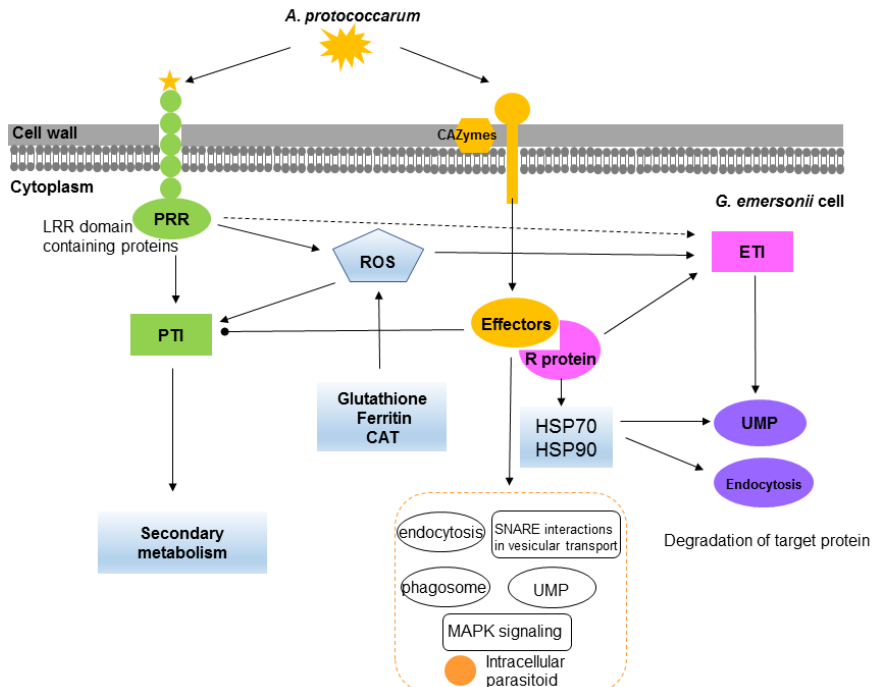
Figure 6. Schematic diagram showing the basic interaction of microalga G. emersonii and endoparasite A. protococcarum . Similar to plant, G. emersonii cells can perceive pathogen via potential PRRs and initiate PTI. Reactive oxygen species (ROS) was rapidly induced in response to infection. Meanwhile, ROS scavenging-related genes (glutathione, ferritin, CAT) were upregulated to eliminate excess ROS. Several HSP70 and HSP90 were upregulated and may serve as putative R genes to recognize the effectors of pathogens and trigger ETI. The ubiquitin–proteasome system (UPS) and endocytosis, which may be involved in regulating apoptotic cell death, were also upregulated to response to the infection. For endoparasite A. protococcarum , genes for carbohydrate-active enzymes, pathogen– host interaction, and putative effectors are significantly upregulated during infection. Endocytosis, phagosome, ubiquitin-mediated proteolysis, and SNARE interactions in vesicular transport pathway represent the KEGG enrichment pathways involved in the modulation of vacuole transport of intracellular